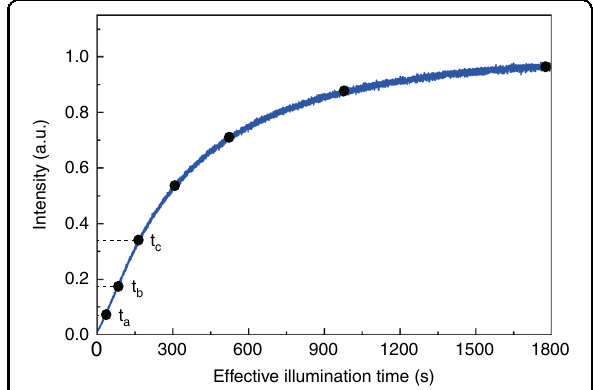
Fig. 6 A calibration curve for pump and probe measurements. Normalized 790 nm PL intensity vs. illumination